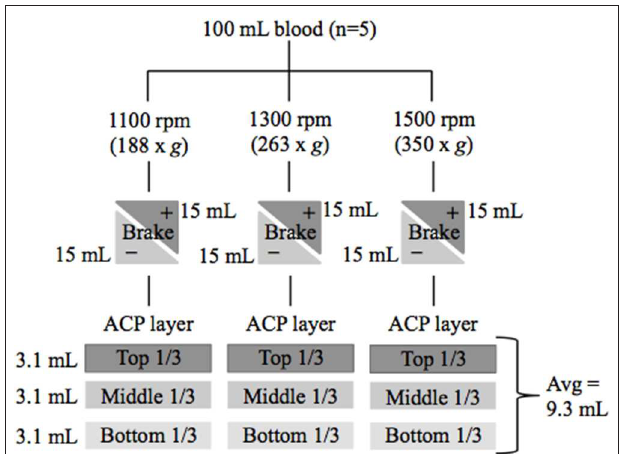
FIGURE 1 | Flow chart of study design. Blood was collected from 5 healthy horses. Platelet rich plasma (PRP) was generated using 6 centrifugation techniques with variations in centrifugation rate and braking. PRP was divided into three layers and CBCs were performed to determine cellular composition. rpm, revolutions per minute; g, g force; ( + ) brake was applied or (–) brake was not applied at end of